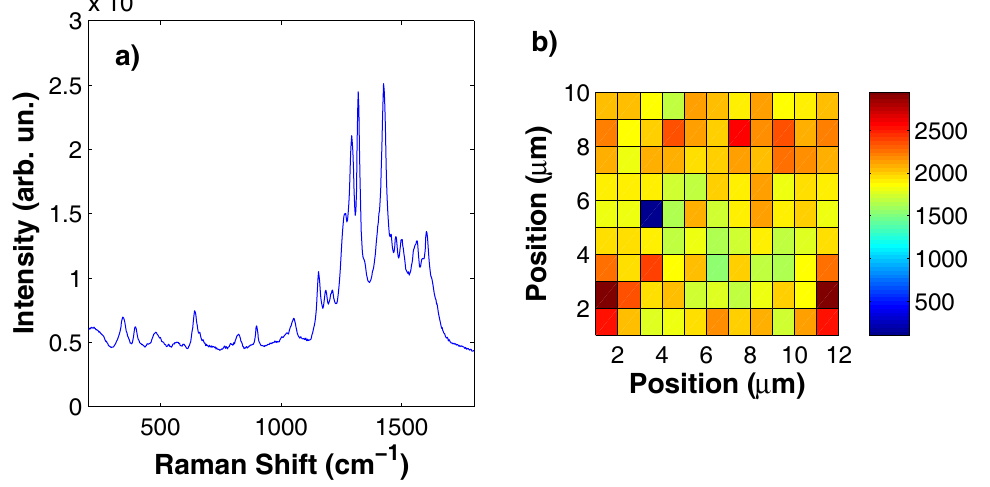
Figure 8. ( a ) SERS spectrum acquired on a silver substrate soaked in an aqueous solution of alizarine at a concentration c = 10 − 4 M. ( b ) Intensity of the Raman peak at 900 cm − 1 as a function of the position on the substrate surface over an area of 10 × 12 µ m 2 . Detection point spacing, 1 µ